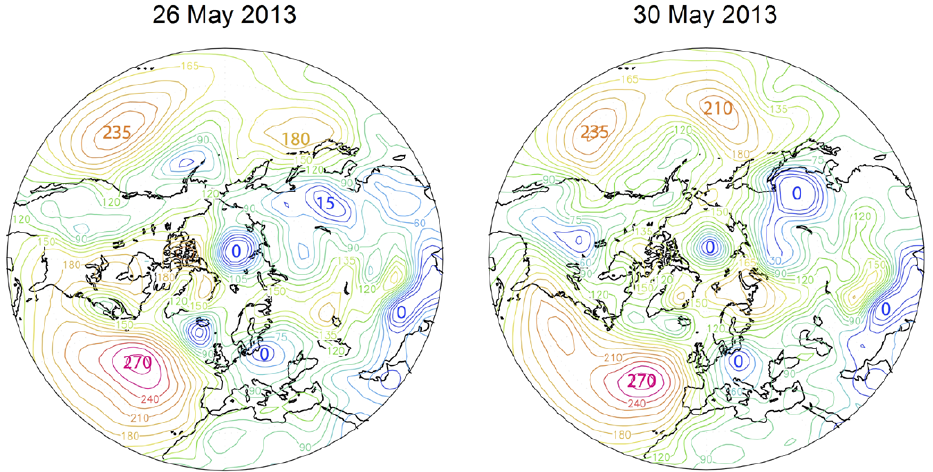
Fig. 2. Geopotential height fields (in meter) at 1000hPa of the Northern Hemisphere for latitudes above 20 degrees. Five-day moving averages, centred on 26 May and 30 May 2013. The geopotential height difference between consecutive isolines is 15m. Based on the NCEP-NCAR Reanalysis data sets (Kistler et al.,